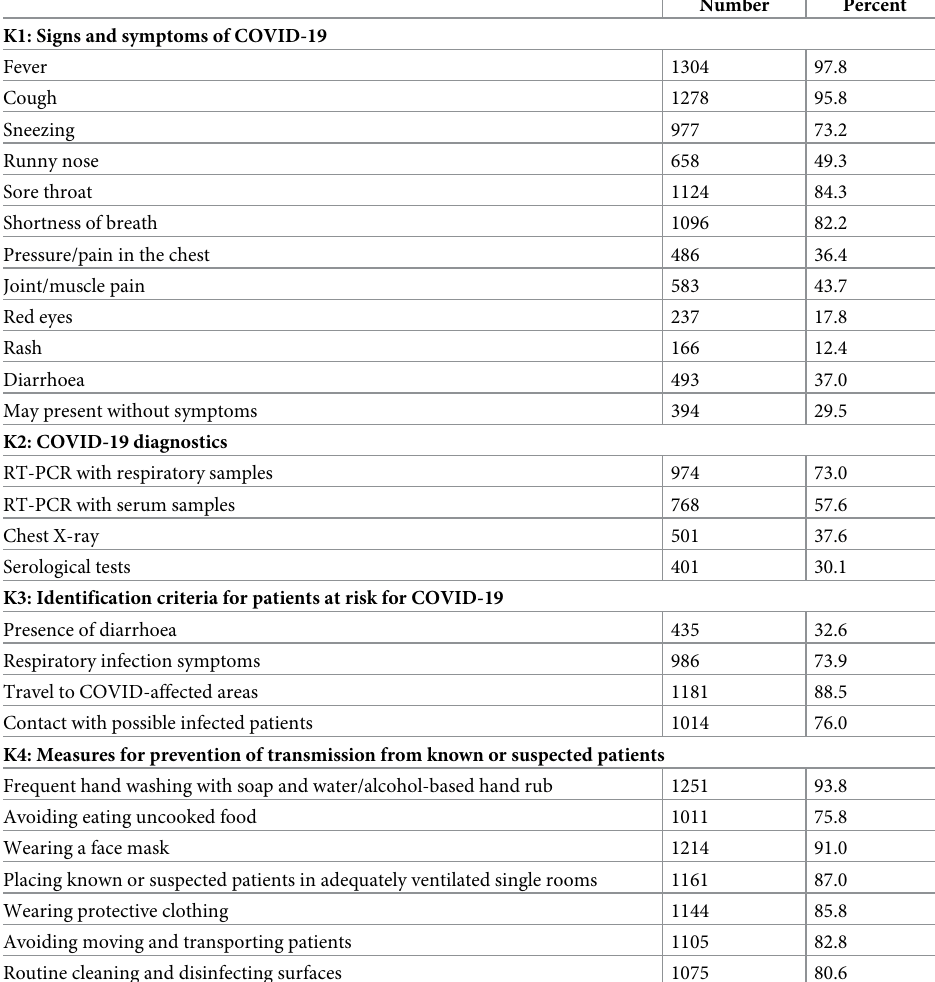
Table 2. The proportions of correct answers about the signs, diagnostic methods, identification criteria, and pre- vention measures regarding COVID-19 given by health professionals. K1: Signs and symptoms of